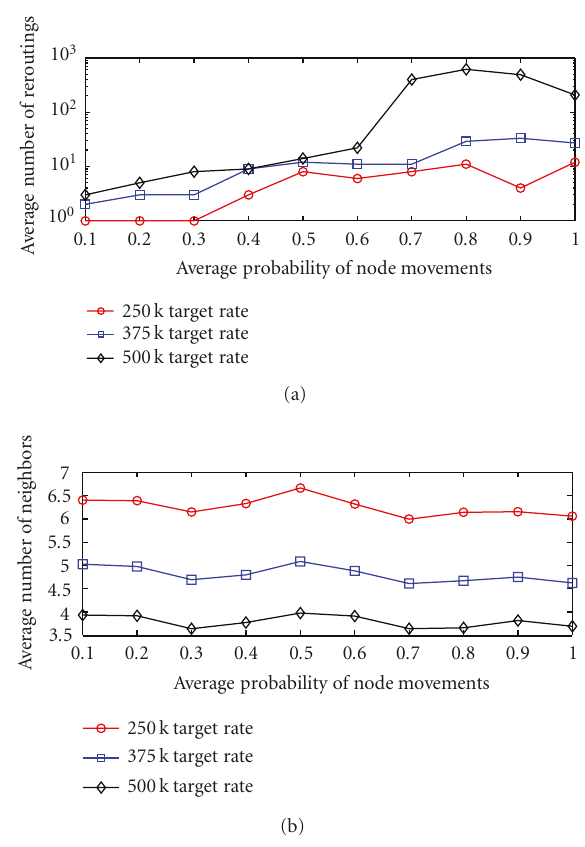
Figure 10: Average number of rerouting and average number of neighbors versus node